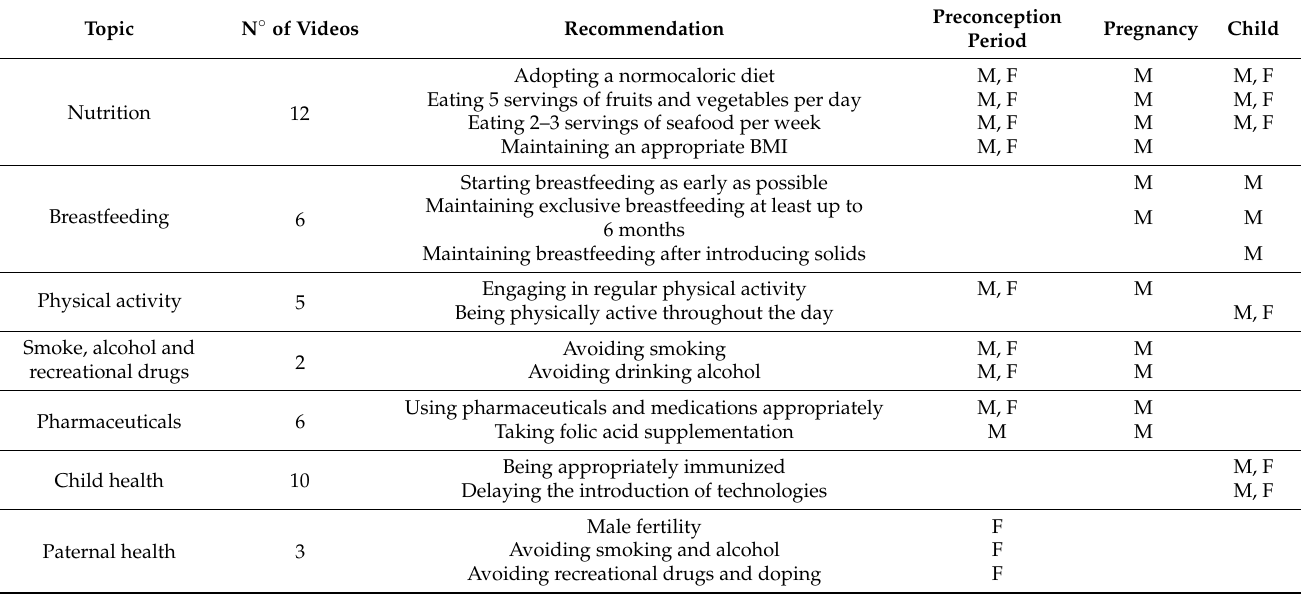
Table 1. List of recommendations translated into